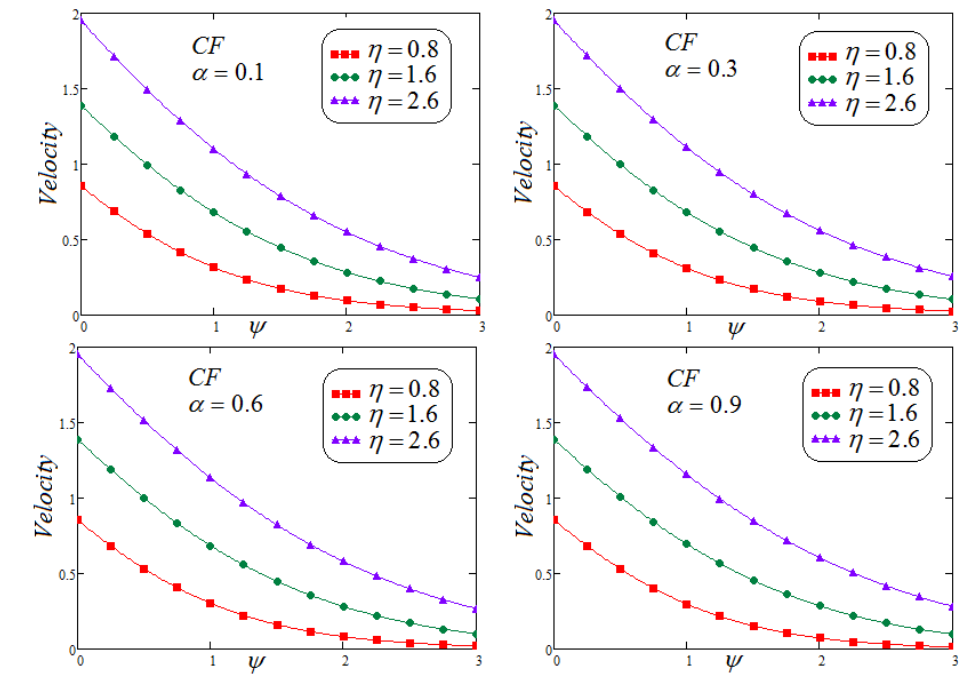
Figure 11. Trace of dimensionless velocity for dissimilar values of η via CF.